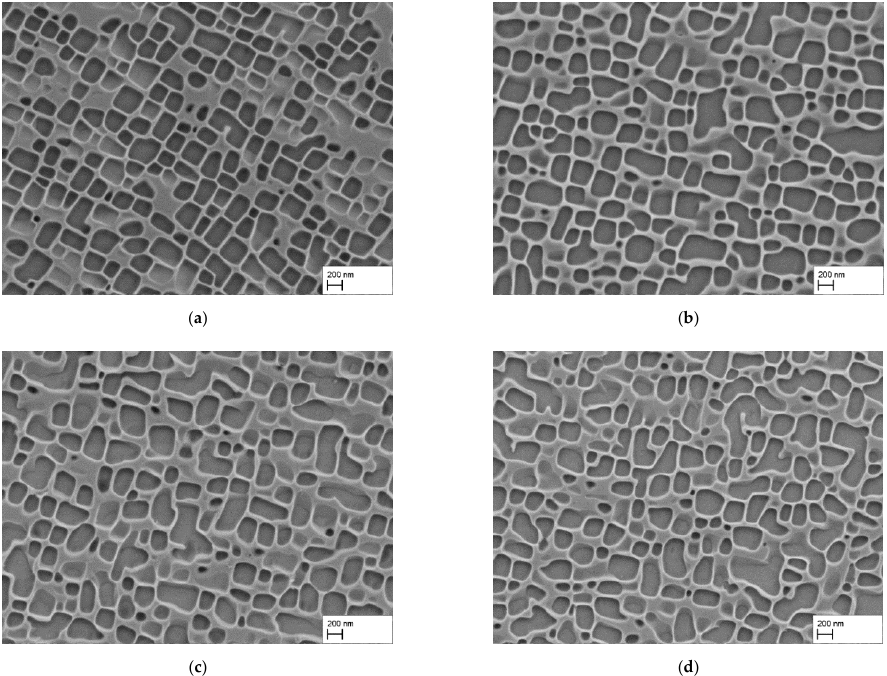
Figure 4. γ / γ′ -microstructure after homogenization and precipitation heat treatments with precipitation times predicted by calculation: ( a ) HT/AC + 980 °C/30 h/AC, ( b ) HT/AC + 930 °C/93 h/AC, ( c )